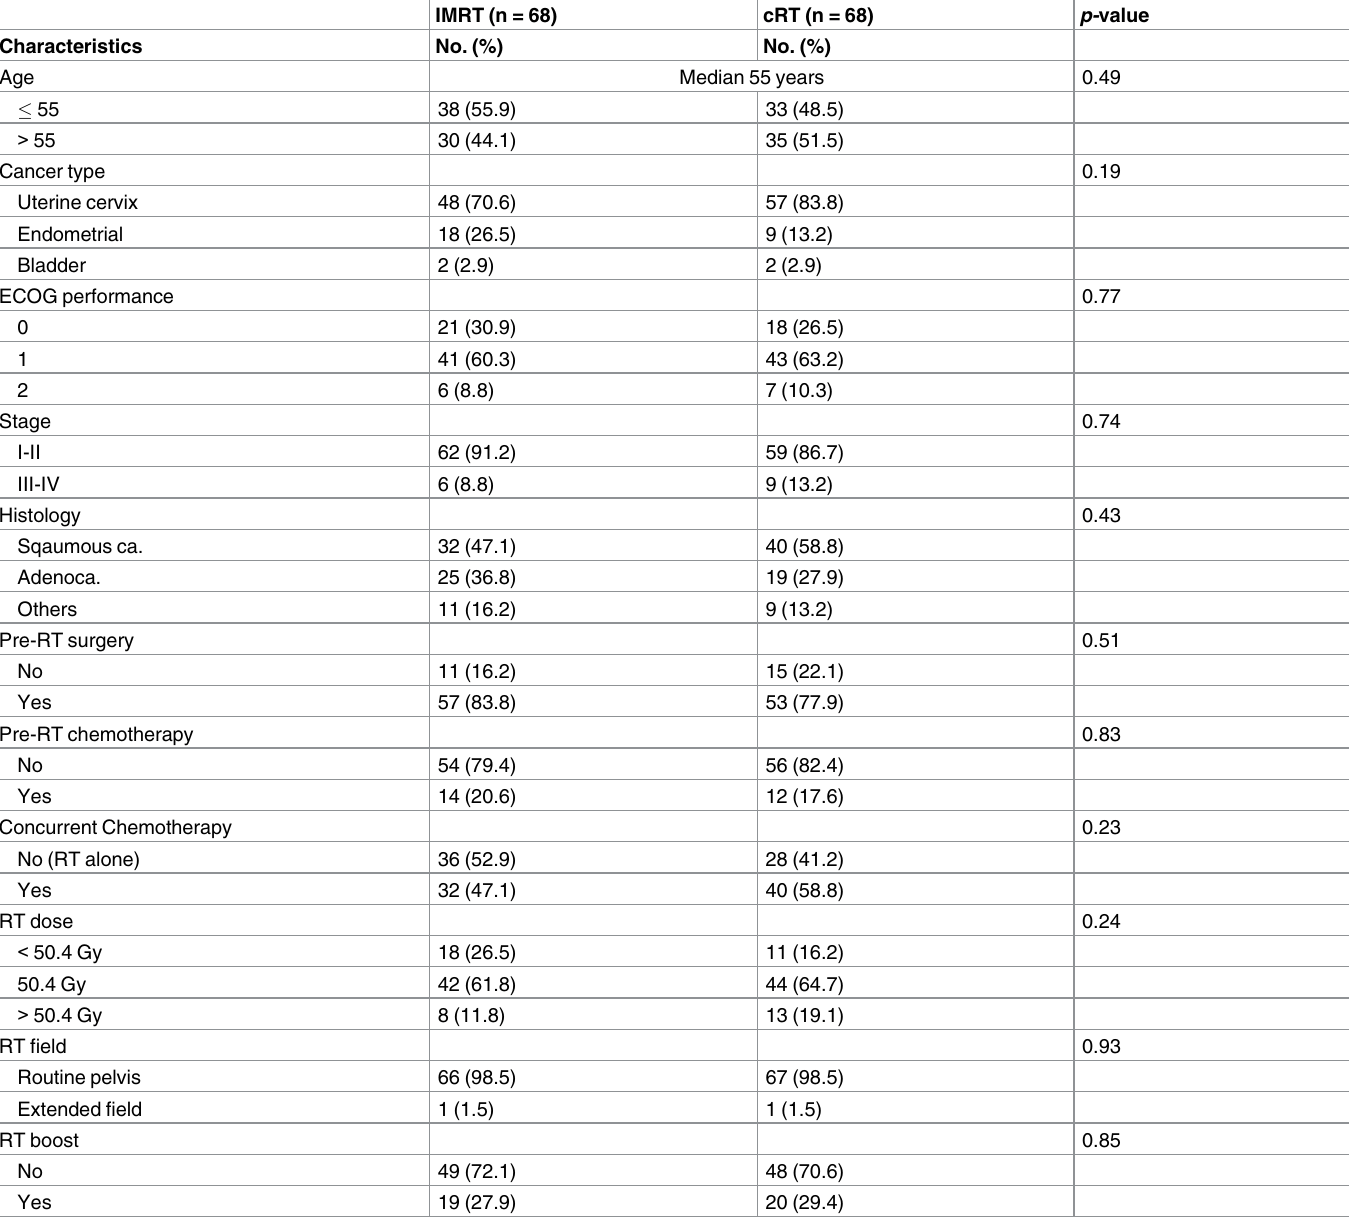
Table 1. Patient